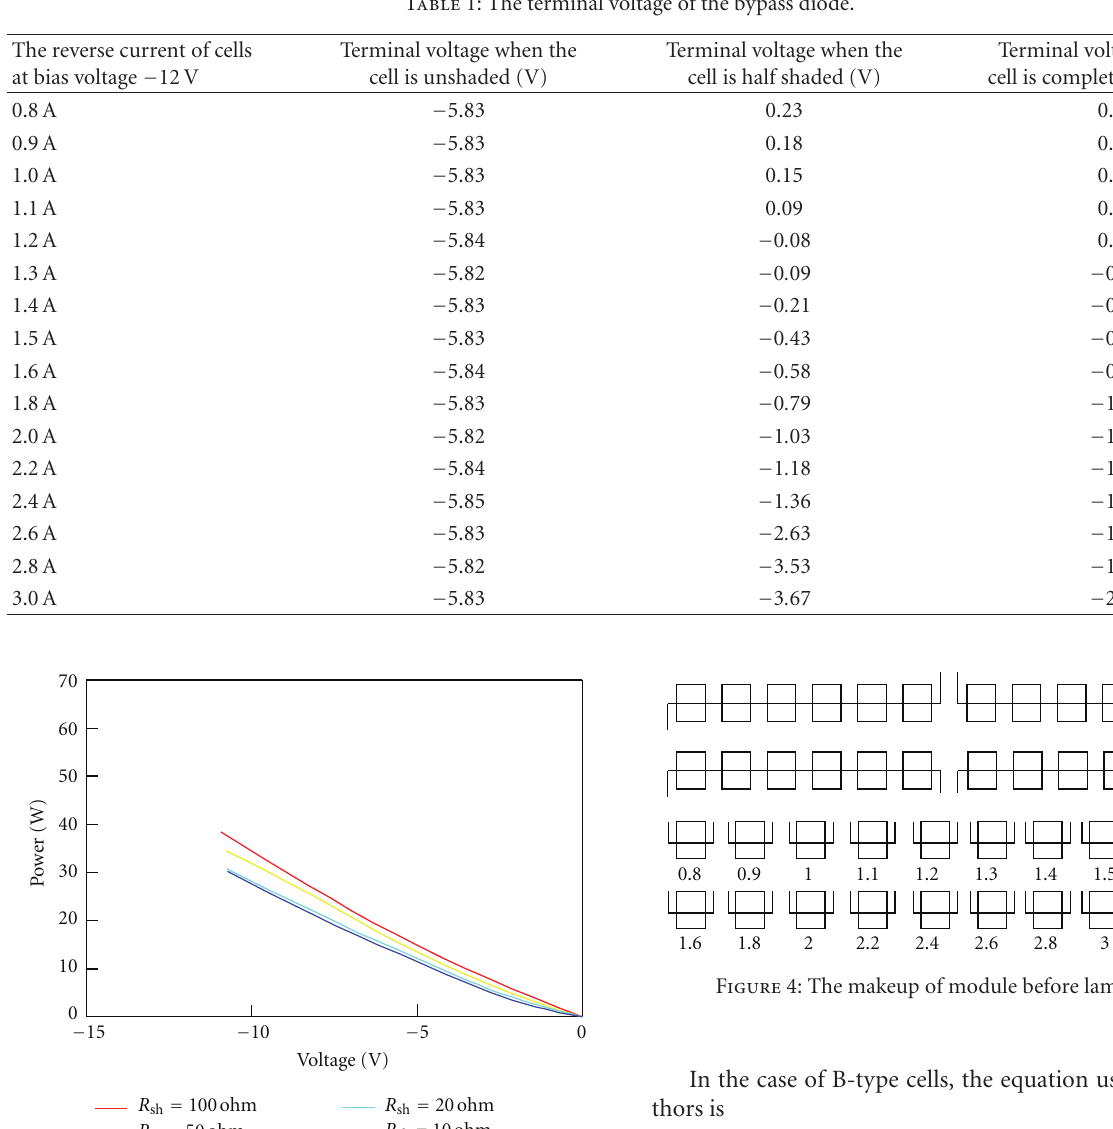
Table 1: The terminal voltage of the bypass diode.